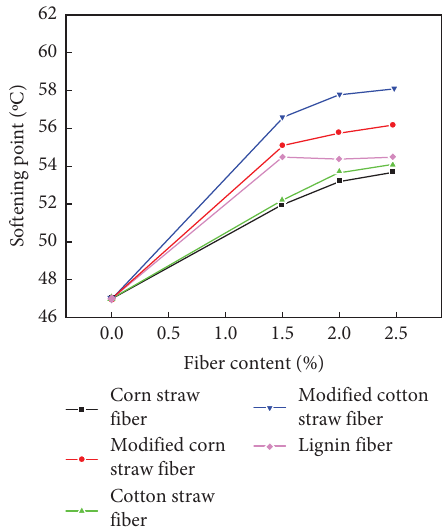
Figure 6: Efects of fber content and type on softening point of asphalt